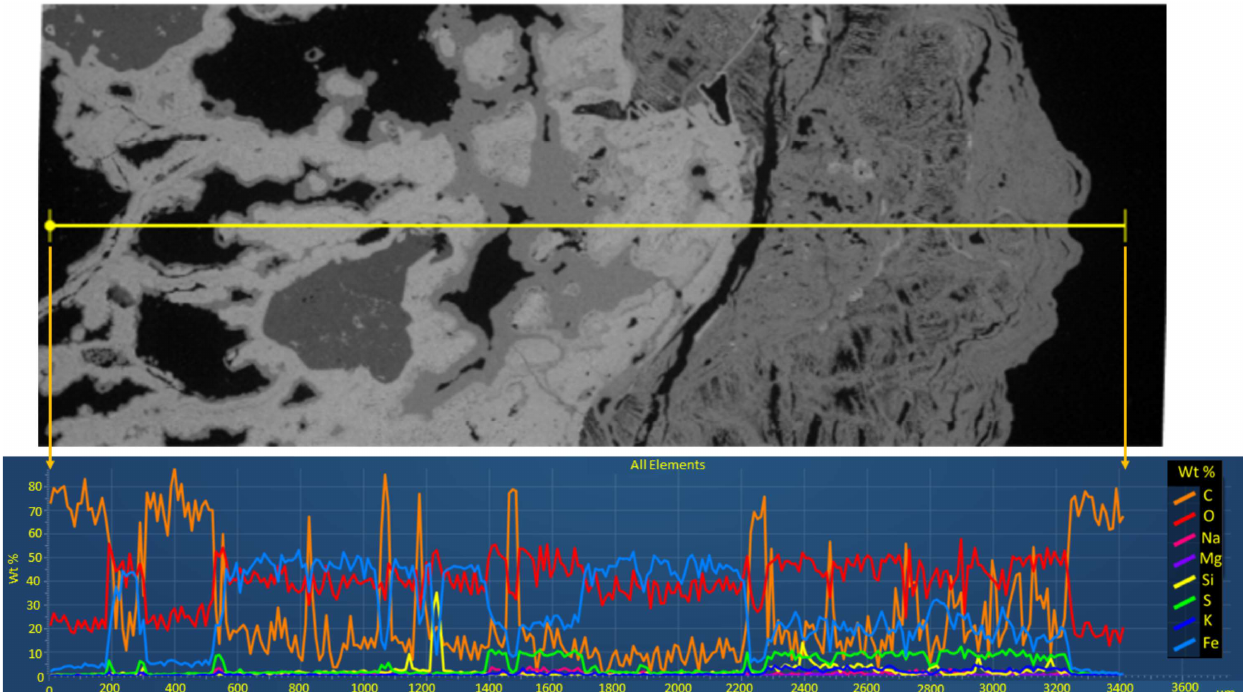
Figure 13. SEM image with the line selected for mapping (top) and the corresponding line mapping (bottom) conducted on a sample from Stefføya. Enhancement in the concentrations of potassium, sodium, and sulfur is related to the jarosite-rich parts of the thin section. More enhancement of these elements is evident as one traverses from the rock on which the jarosite is formed to the right (jarosite covered surface). Iron and oxygen are the main components of the rock in addition to that of jarosite.